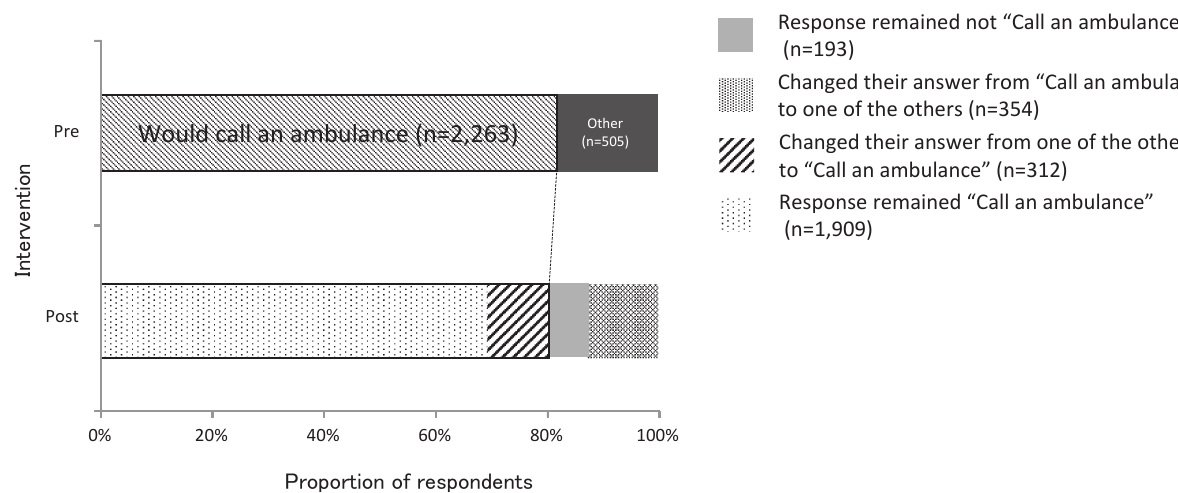
Figure 2. Proportion of respondents who selected “ immediately call an ambulance ” at stroke onset in the intervention areas (Akita & Kure) in the pre- and the post-intervention